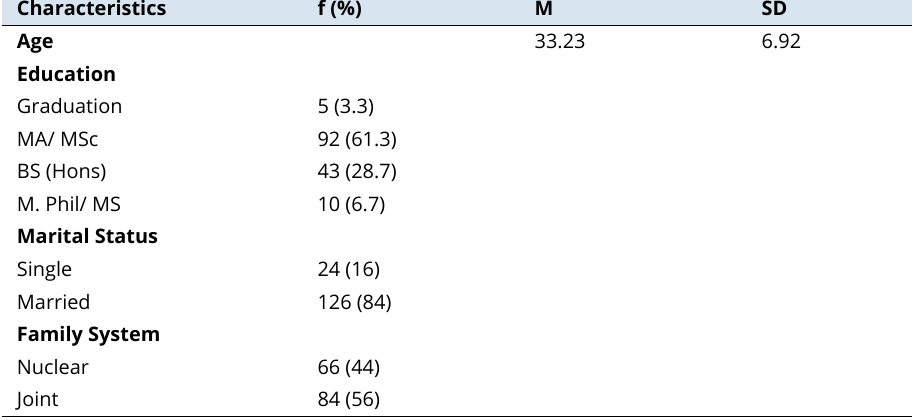
Demographics Characteristics of the Sample (N=150)